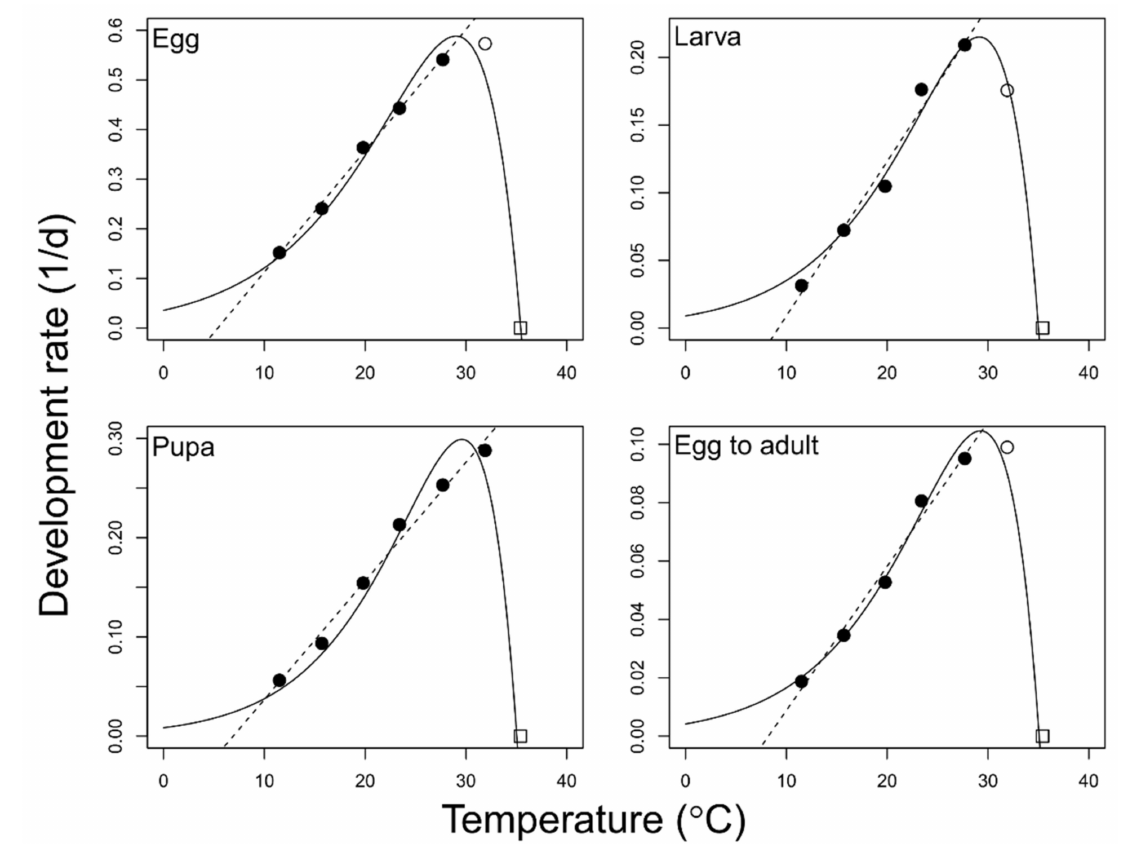
Figure 1. Temperature-dependent development rate models for Feltiella acarisuga . Linear (dashed lines) and non-linear Logan-6 (solid lines) models. Open circle data points were excluded in the linear regression analysis. All data except for open square data points (35.4 ◦ C) were used in the curve fitting. Table 2. Estimated parameter values of the linear development rate model for Feltiella acarisuga .